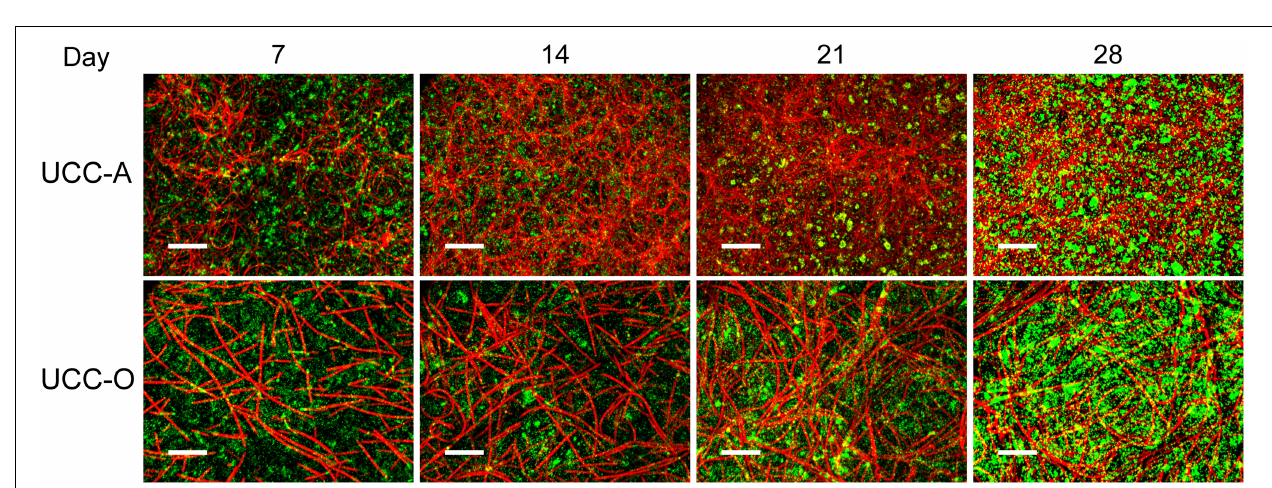
and (D) flow cytometry (total cell counts). Values are averages calculated from triplicate biological replicates of three experiments (a total of nine samples). Error bars indicate 95% confidence intervals of the mean.